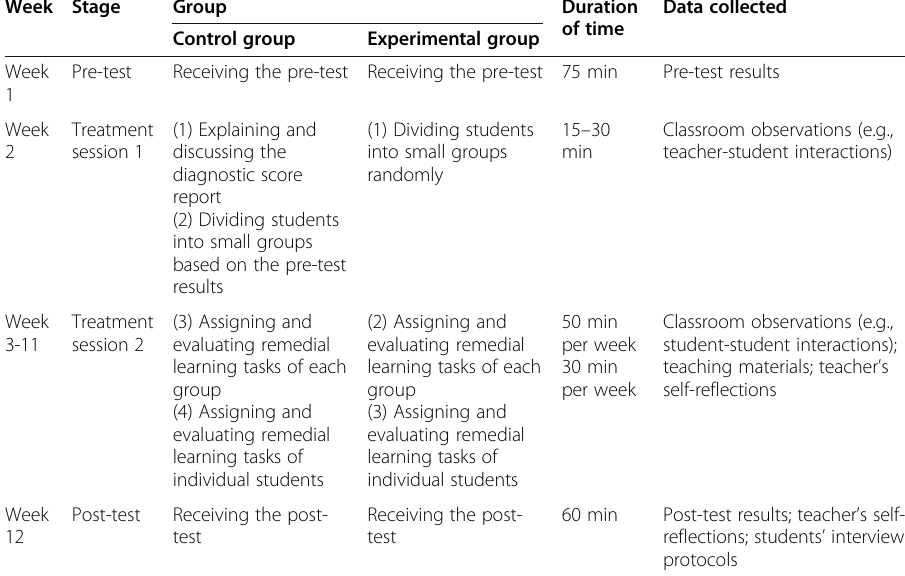
Table 3 Research